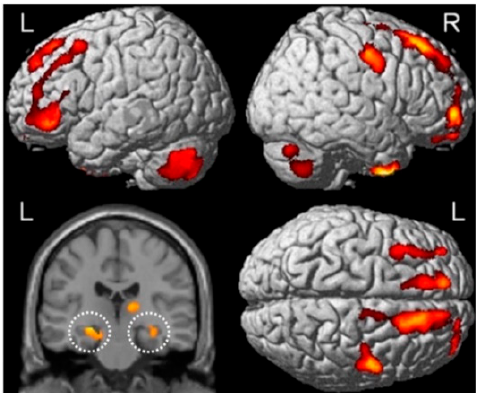
Figure 2. Voxel-based morphometry identified gray matter density declines (warm colours) be- tween pre-treatment baseline and 1-month post-chemotherapy, notably within bilateral hippocampal and parahippocampal regions (white dashed circles). Abbreviations: R, right hemisphere; L, left hemisphere. Adapted from McDonald et al. [107].